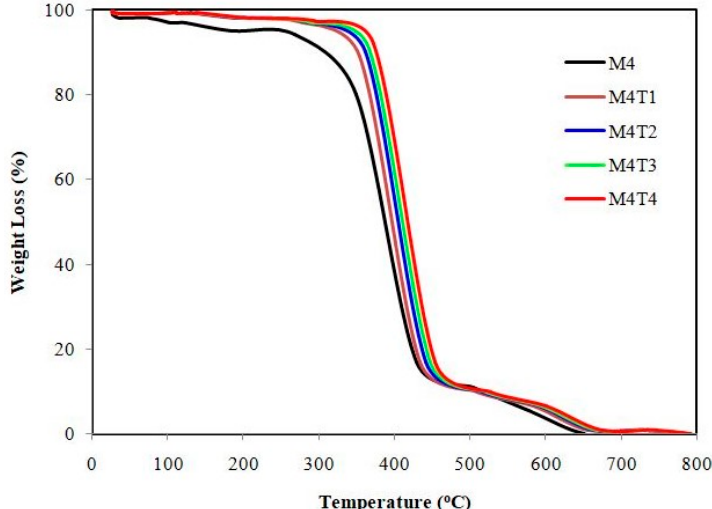
Figure 4. Thermograms of fabricated membranes.